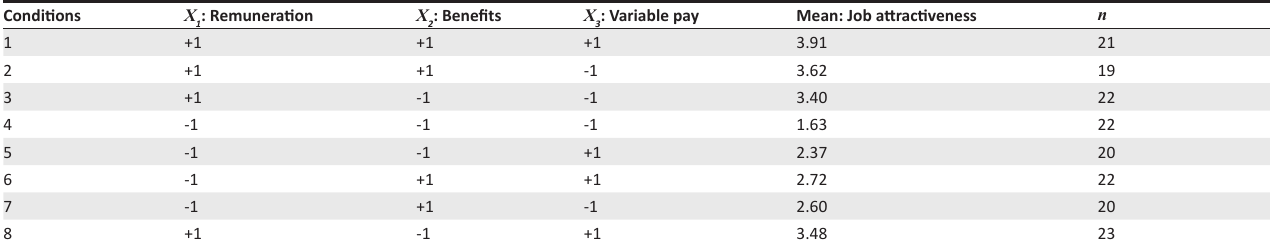
TABLE 1: A 2 3 design showing the eight experimental groups and the mean score for perceived job attractiveness achieved for